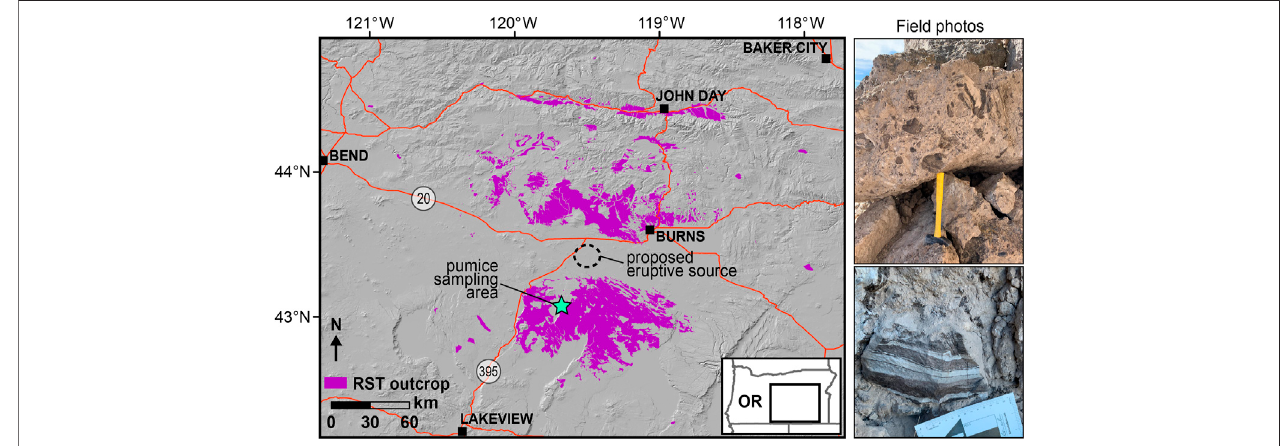
FIGURE 1 | Map showing extent of known outcrops of the Rattlesnake Tuff (RST) in eastern Oregon and sampled pumices in situ . Banded pumices can be found throughout the RST, but the sampling area for this study is a location where the pumices are large and most abundant. Mapping compilation is from the Oregon Department of Geology and Mineral Industries (DOGAMI), Streck and Grunder (1995), Isom and Streck (2016), Isom (2017), Cruz and Streck (2017), and more recent mapping from EdMap projects completed by Rachel Sweeten, while af fi liated with Portland State University, Portland, OR. New outcrops found byStreck are also included. Proposed source for the RST is from Streck and Grunder (1995). Highways 20 and 395 are labeled.